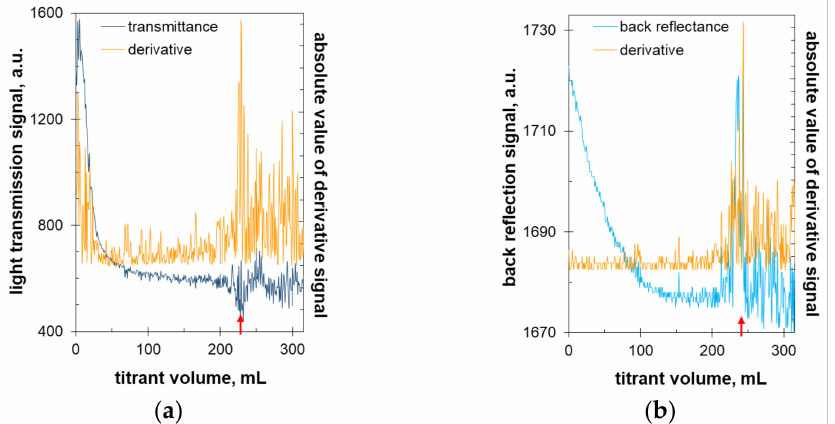
Figure 7. Turbidimetric titration of 6 mM carrageenan solution with 1 mM polyDADMAC solution in ( a ) light transmission and ( b ) back reflection modes. The red arrows mark critical points where large oscillations in the optical signal